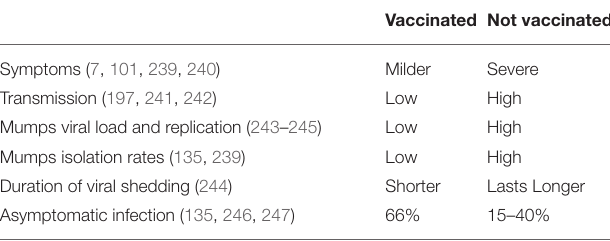
TABLE 2 | Differences between Mumps vaccinated and unvaccinated